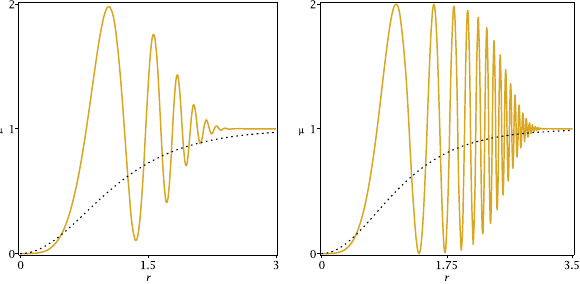
Fig. 9 Permeability μ 3 ( r ) (golden line) for n 1 = 1 and n 2 equal to 5 (left) and 10 (right). For comparison, the choice μ 3 = | ϕ 1 | 2 is shown as a dotted